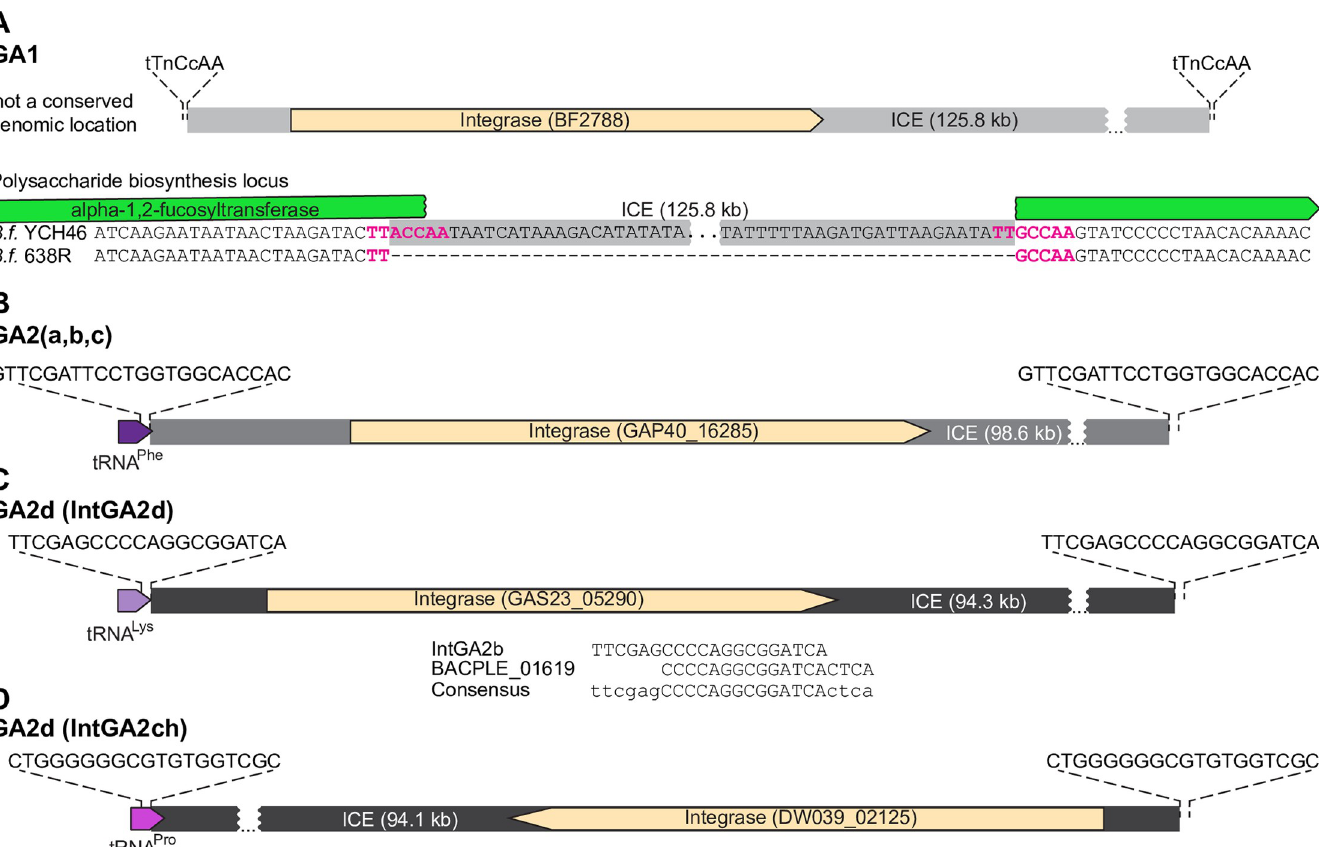
Fig 5. Sequence specificity of the GA1 and GA2 integrases in Bacteroides and Parabacteroides genomes. A. GA1 recombinase and integration site of the B . fragilis YCH46 ICE (ICE spans BF2788 to BF2921). The insertion of the GA1 ICE in the B . fragilis YCH46 genome relative to the 638R genome is shown. B. The recombinase and integration site of the GA2(a,b,c) showing the GA2b region from B . uniformis BIOML-A2 as an example (GAP40_16280 to GAP40_16650 and GAP40_07160 to GAP40_07320). This ICE integrates into the tRNA Phe gene. C, D . The recombinases and integration sites of two different GA2d ICE. Panel C shows the GA2d region from B . uniformis BIOML-A77 (GAS23_04785 to GAS23_05290) with the IntGA2d integrase. Shown below are the proposed recognition sequences deduced from BIOML-A77 and BIOML-A84 comparison, the sequence reported for B . plebeius DSM 17135 (a PUL ICE), and the proposed consensus sequence recognized by IntGA2d. This integrase recognizes the sequence shown in tRNA Lys genes. Panel D shows the GA2d ICE from B . uniformis AF39-16AC (DW039_02125 to DW039_02640) which harbors the IntGA2ch recombinase which integrates at a tRNA Pro gene sequence.